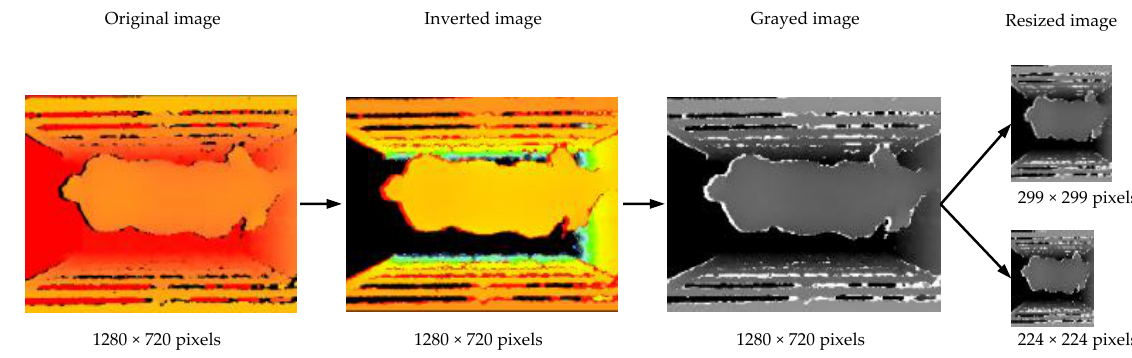
Figure 5. Image preprocessing process.